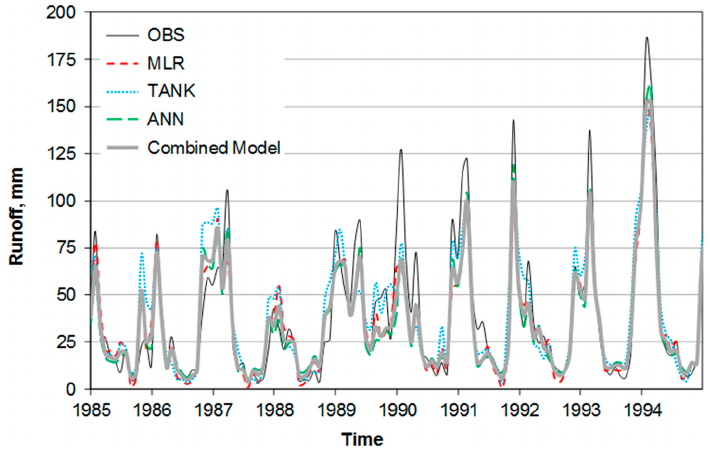
Figure 4. Example comparison of hydrographs from 1985 to 1994 simulated by individual and combined hydrologic models with observed runoff. Table 2. Performance comparison of the individual models and combined hydrologic models to observed runoff.